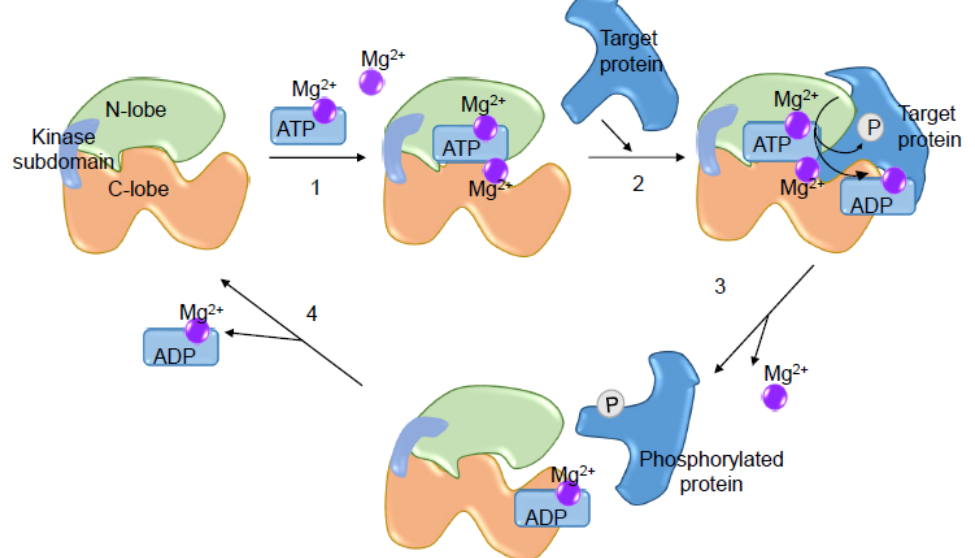
Figure 4. Importance of Mg 2+ for the kinase catalytic activity . Two Mg 2+ molecules are required for enzymatic activity and phosphoryl transfer: one bound to ATP (Mg-ATP) situated between the